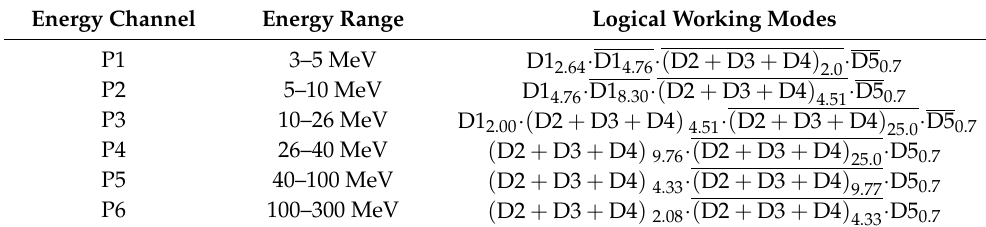
Table 2. Logical working modes of high-energy proton probe.